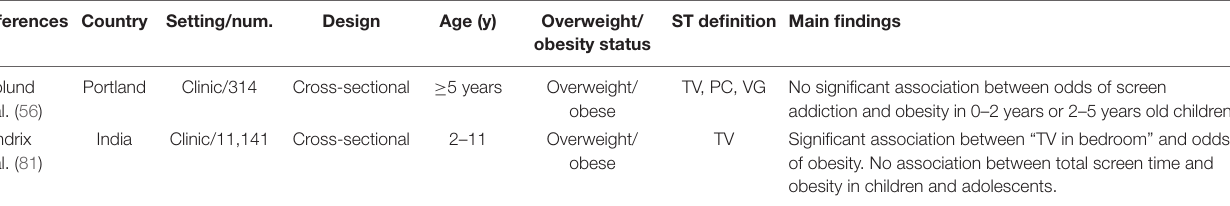
TABLE 3 | The characteristics of studies that were included in the two-class meta-analysis of comparison of odds of screen addiction between overweigh/obese vs. non-overweight/obese children and adolescents. References Country Setting/num.